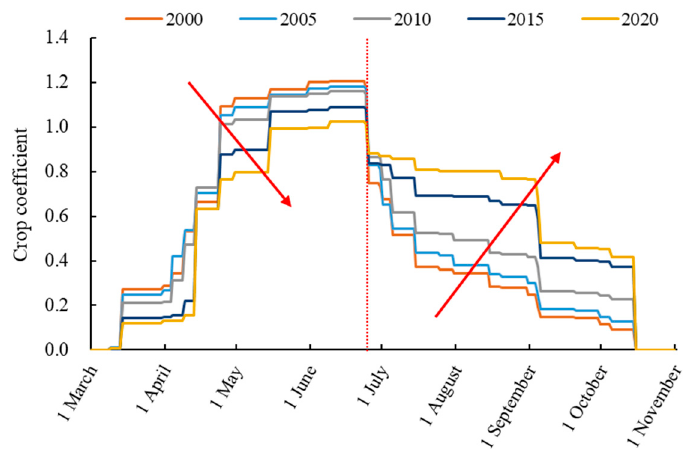
Figure 5. Daily crop coefficient based on the crop planting area. (Arrows indicate the changing trend of crop coefficients from 2000 to 2020).